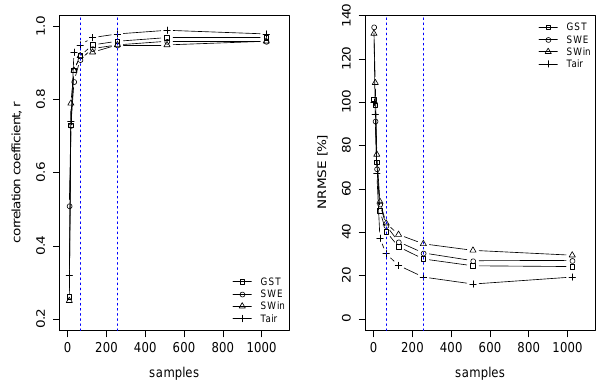
Fig. 9. The predictive power of the lumped scheme is assessed using the (a) r-value (b) NRMSE at resolutions 2–400 samples with re- spect to baseline distributed grid simulation. The majority of perfor- mance is gained until 64 samples (first dotted line). After 258 sam- ples a reasonably stable performance is achieved (second dotted